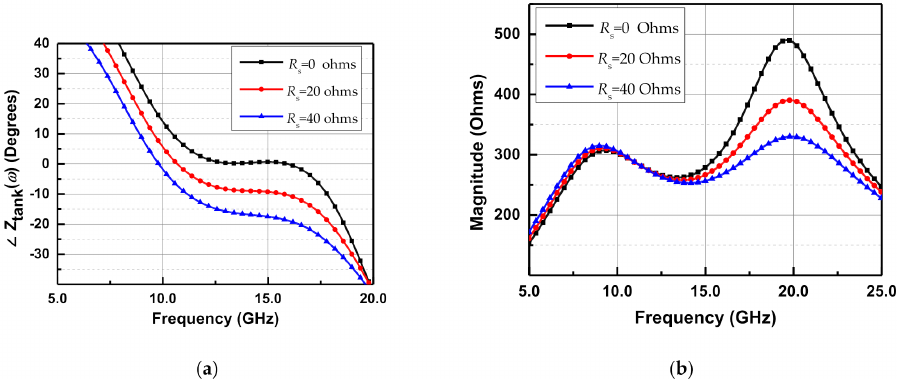
Figure 8. Loss of the inductor L s is taken into consideration based on the tank in Figure 3b. ( a ) Phase responses of the tank. ( b ) Magnitude responses of the